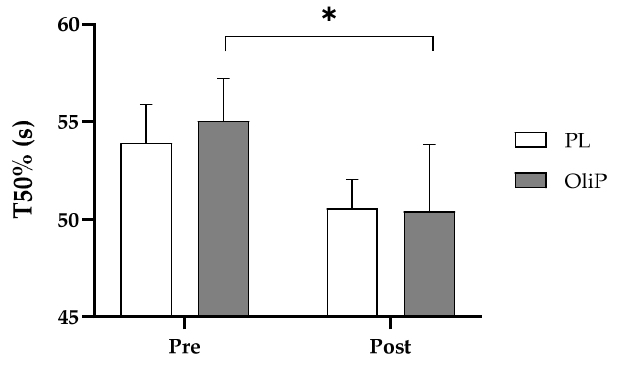
Figure 3. Summary respiratory and economy differences at lactate threshold (LT1) intensity pre and